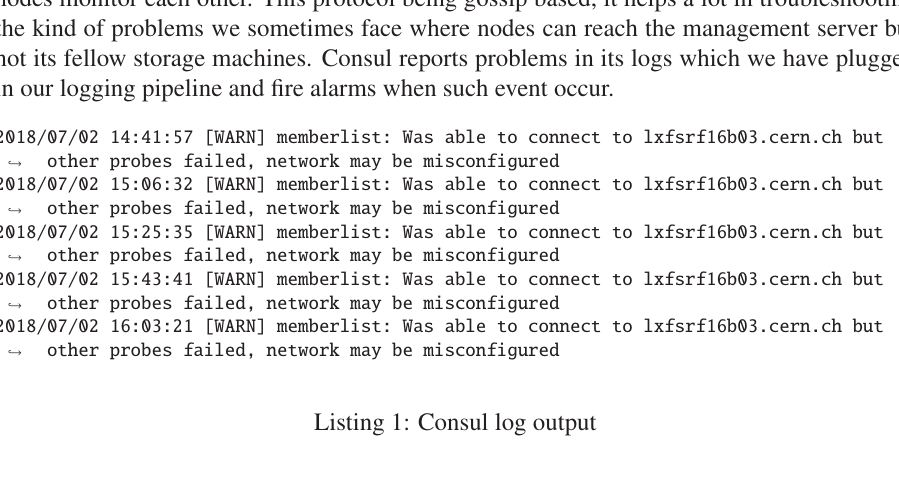
Figure 2. Namespace metadata load time